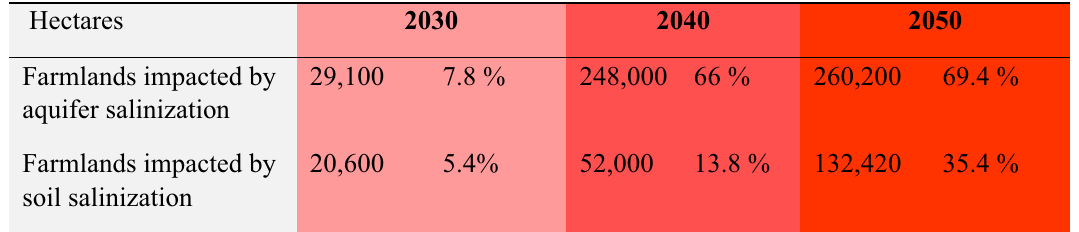
Table 2. Results of scenario-based Lake Urmia drought impacts on the productivity of farmlands in LUB. Numbers and percentages indicate aquifer and soil salinization impacts on the current farmlands, with an area of about 375,000